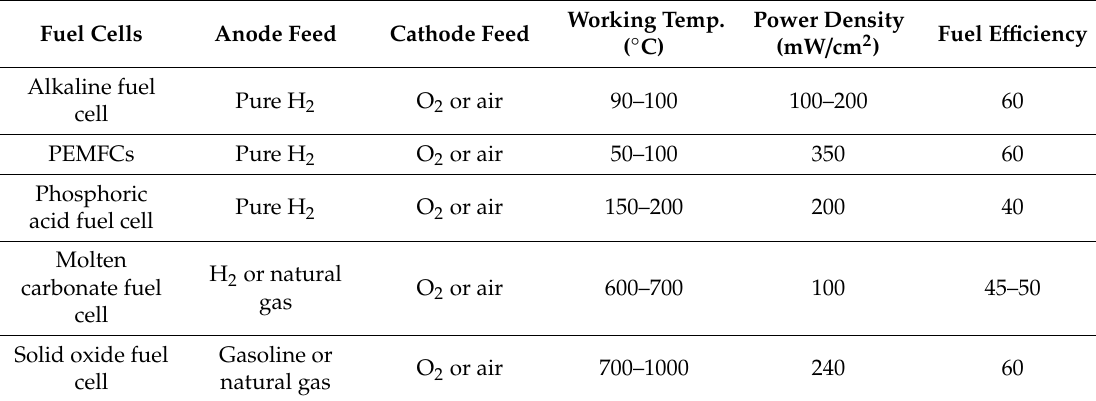
Table 2. Typical characteristics of various fuel cell systems. Reproduced with permission from